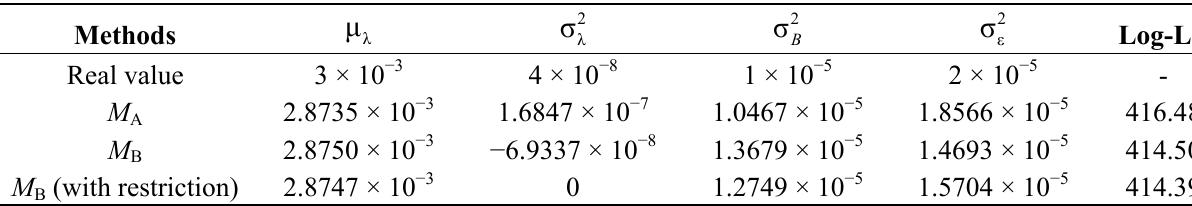
Table 1. Comparisons of the two maximum likelihood estimation (MLE) methods with simulated degradation